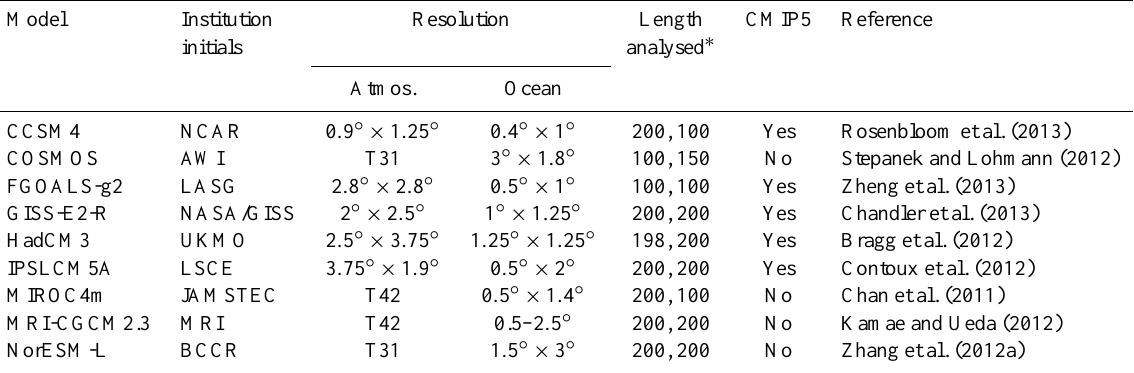
Table 1. Simulations contributing to the PlioMIP ensemble (see Sect. 2.1 and Haywood et al., 2013, for details). The resolution given relates to the deep tropics for models with a varying ocean resolution. The length analysed represents the number of model years uploaded to the PlioMIP database – the simulation is often much